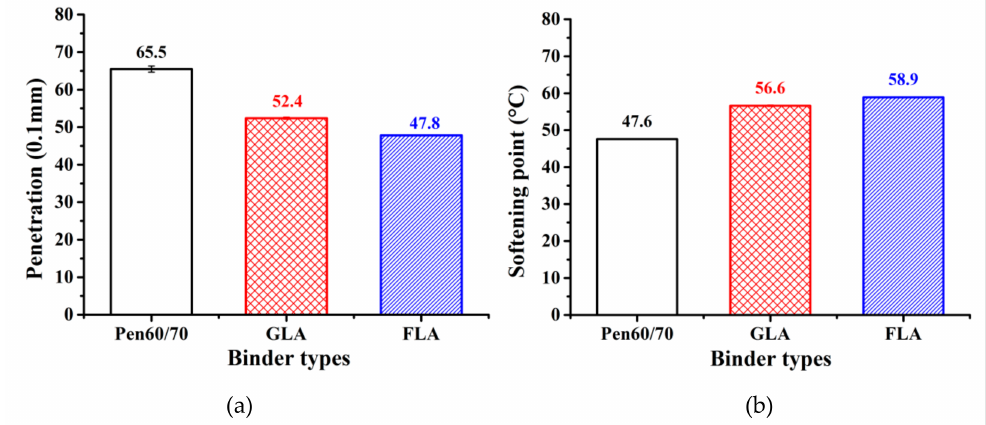
Figure 2. Bitumen empirical test results: ( a ) penetration and ( b ) softening